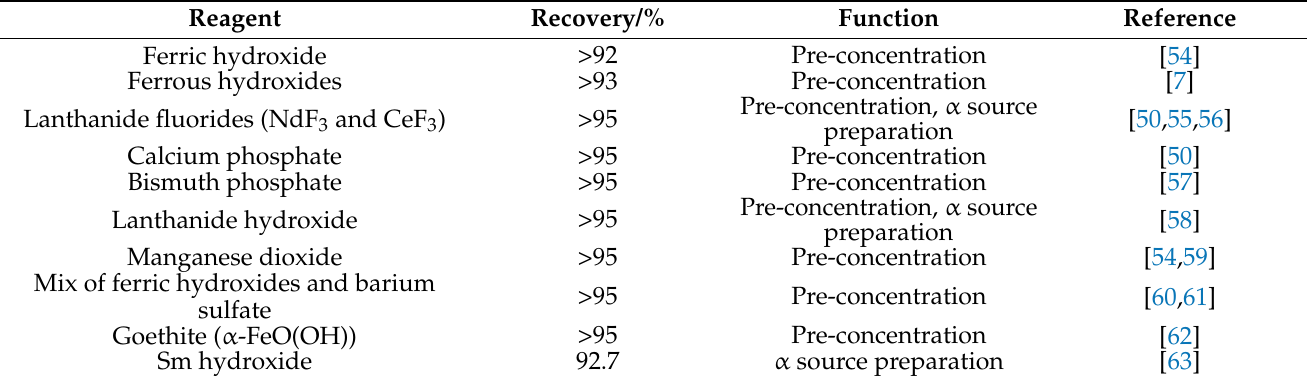
Table 4. The most frequently used reagents for the coprecipitation of 241